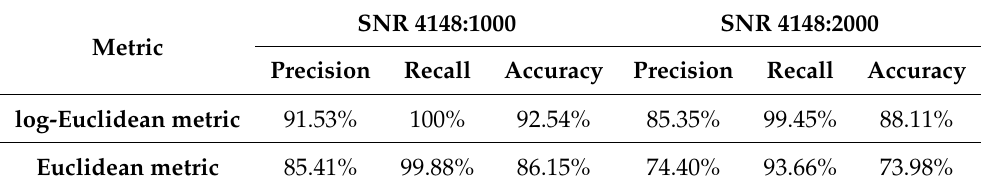
Figure 10. Denoising effects of different metrics (log scale). Table 1. Comparison of denoising